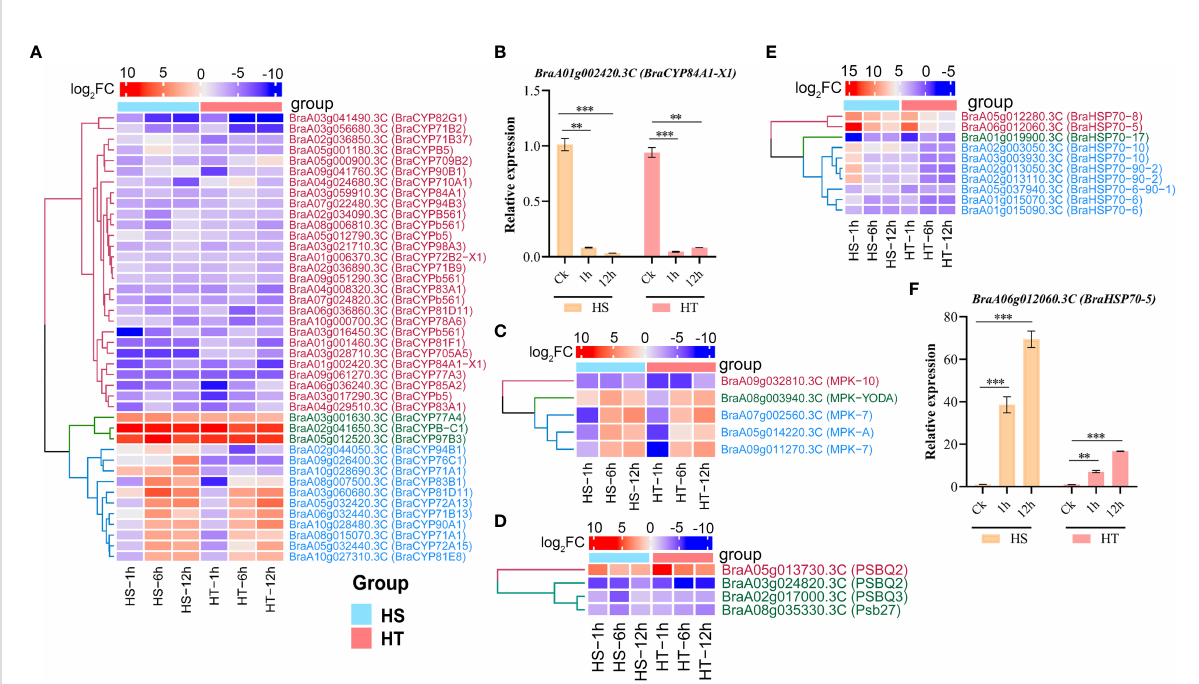
FIGURE 5 Heatmaps of up- and down-regulated genes in heat-sensitive (3T-6) and heat-tolerant (Youlu-501) Chinese fl owering cabbage related to stress at different times and con fi rmation of two DEGs through RT-qPCR analysis. (A) Number of DEGs of cytochrome P450 gene family at four heat- stress time points; (B) BraA01g002420.3C ( BraCYP84A1-X1 cytochrome P450 84A1 isoform X1) showing similar expression pattern in RNA-seq data; Heatmaps of MAPK (C) , photosystem II (D) , and HSPs (E) related genes in HS and HT varieties under heat stress; (F) Con fi rmation